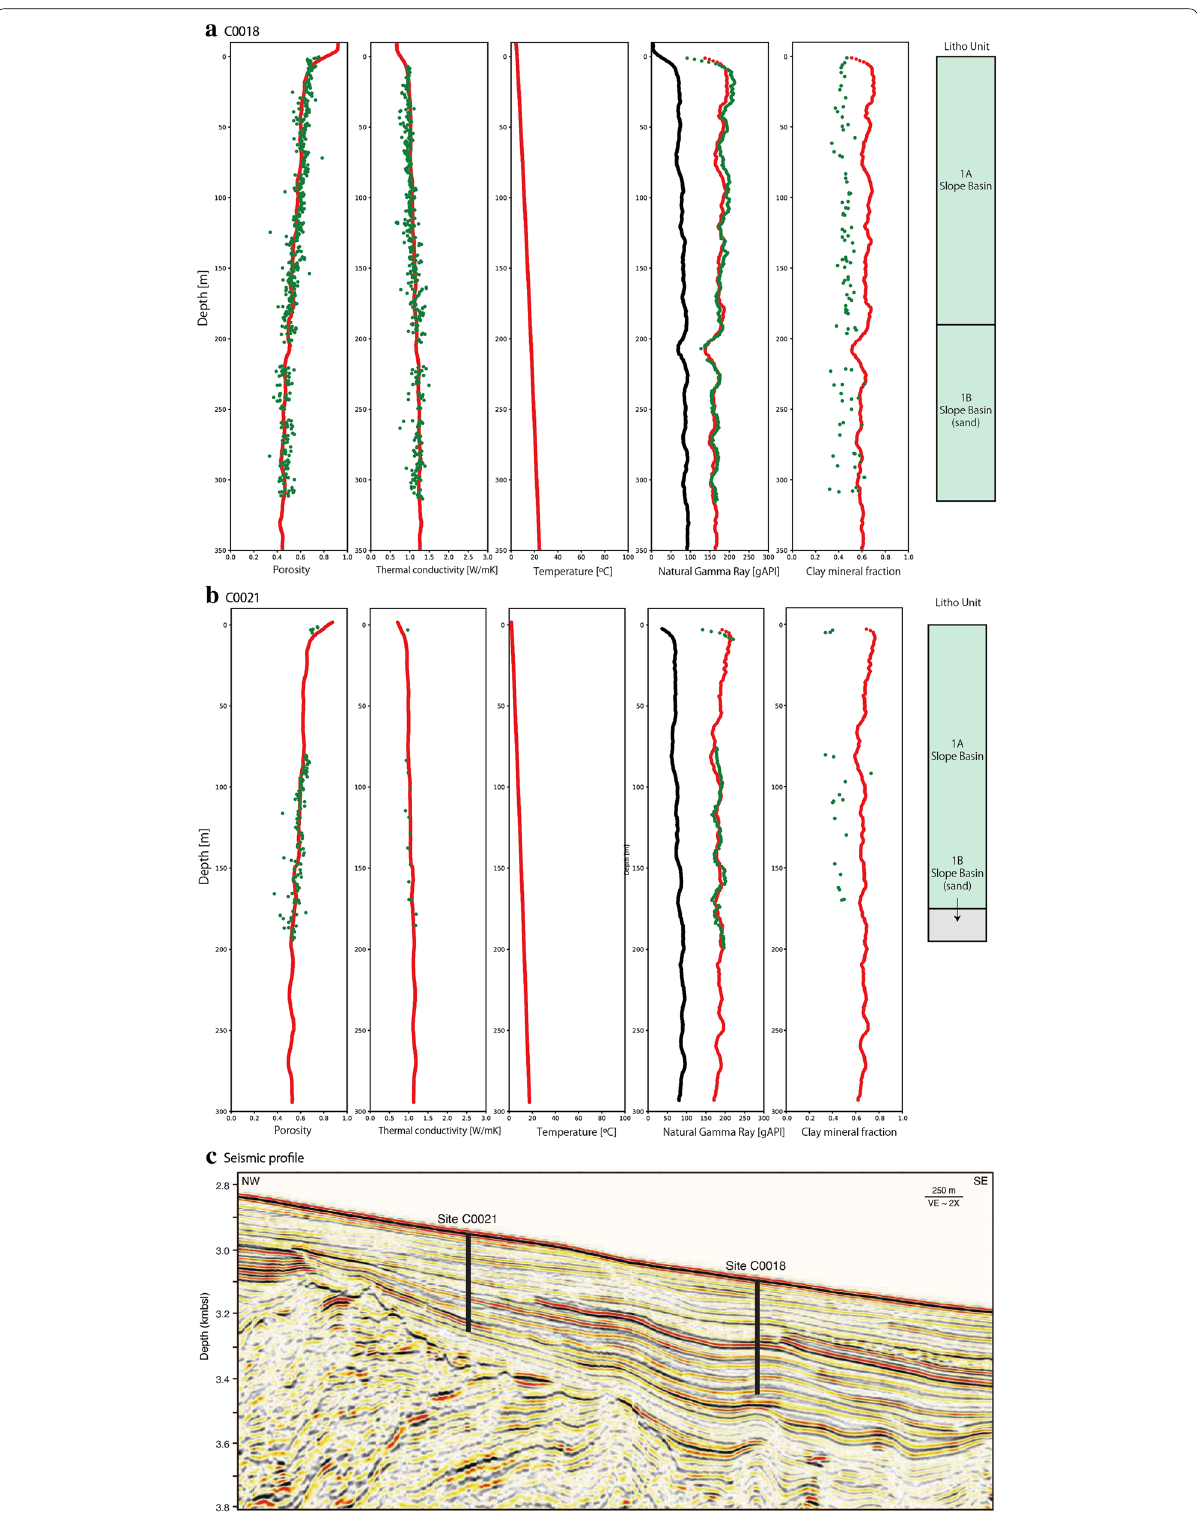
Fig. 4 Data from the slope sites. a Site C0018, b site C0021, and c a seismic profile around the slope apron after Figure F3 of Strasser et al. (2014d). Symbols are the same as in Fig.